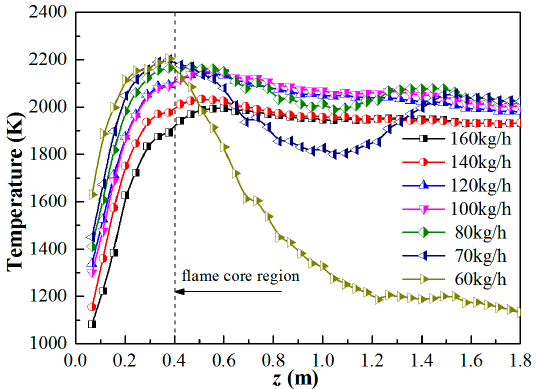
Figure 16. Temperature profile along the burner axis for different oil feed rates.